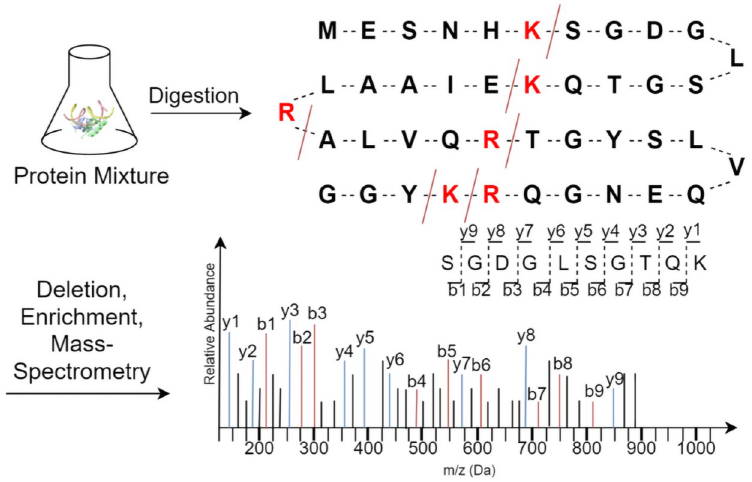
Fig 1. Process of generating MS/MS spectra from a protein mixture using mass-spectrometry analysis. Protein in the mixture are broken into peptides using the enzyme called trypsin which breaks the protein strings at K and R bases generating peptides of varying sizes. This peptide mixture is then refined and peptides are moved through mass- spectrometer which generates an MS/MS spectrum for each different peptide.